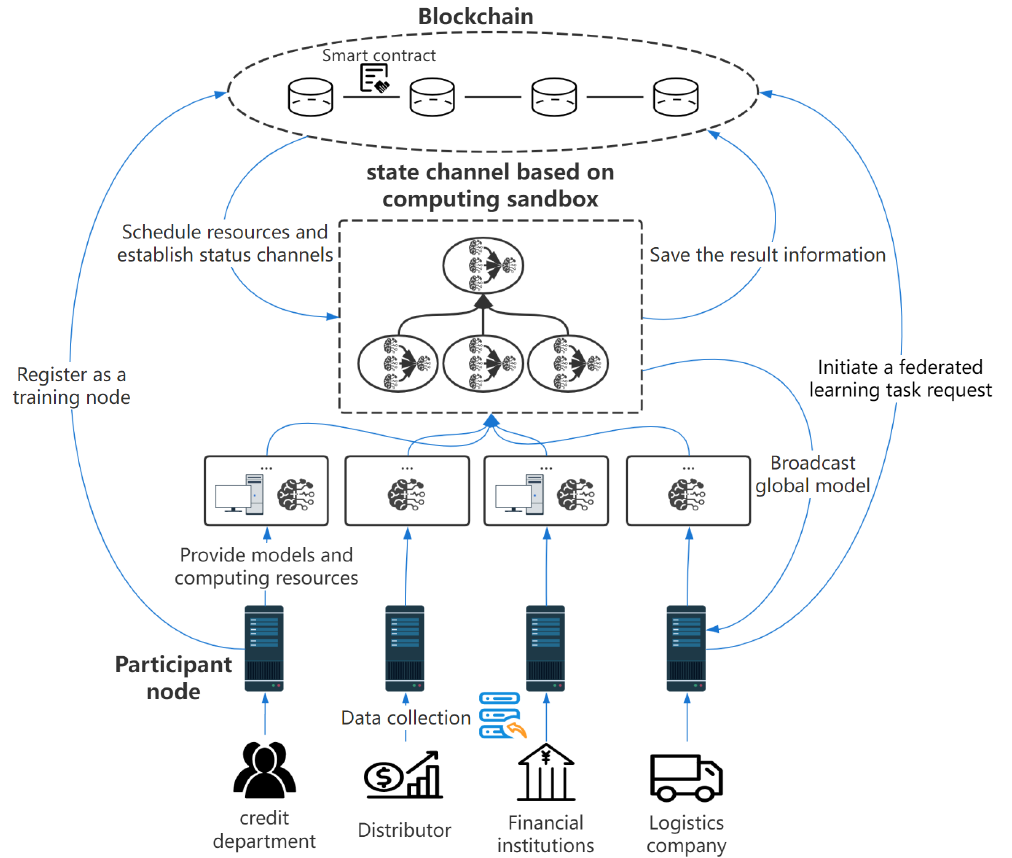
Figure 1. Federated Learning Training Framework Based on State